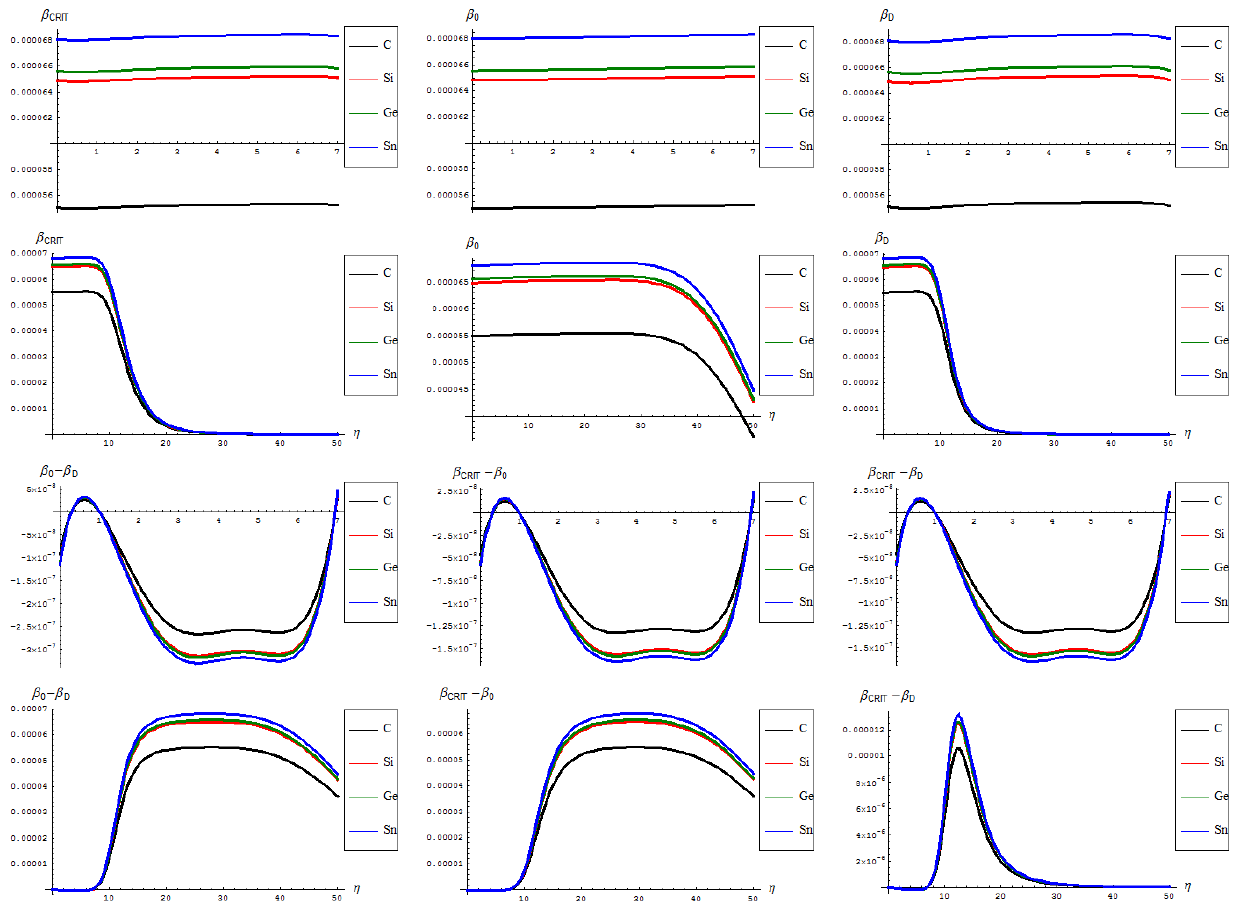
Figure 4. The critical (left column), forming (middle column) and transforming (right column) of SWw in Figure 2, as based on Equation (16) on the short (first upper row) and long range (second upper row), and of their respective